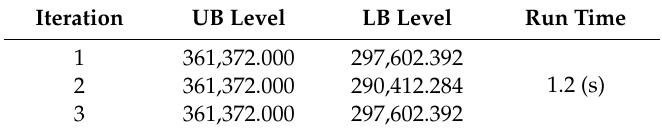
Table 3. Upper bound (UB), lower bound (LB) behavior, and the model run time. Iteration UB Level LB Level Run